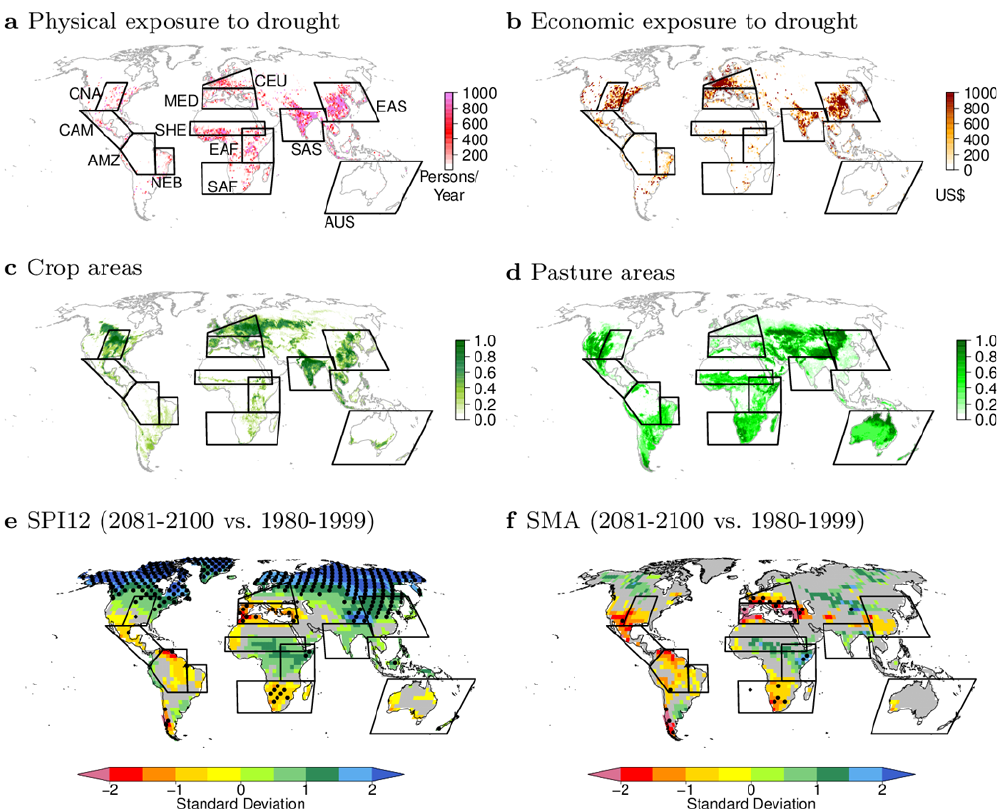
Fig. 1. Exposure to drought, land uses and future changes of drought in CMIP5 projections. (a) Physical exposure to drought measured by the number of persons exposed to drought per year over 1980–2001. (b) Economic exposure to drought in 1980–2001 measured by the expected average annual Gross Domestic Product GDP (2007 as the year of reference) exposed to drought (in US$, year 2000 equivalent). (c) Crop areas as grid cell percentages for the year 2000. (d) Pasture areas as grid cell percentages for the year 2000. (e) Multi-GCM averages of multi-year average changes in 12month Standardised Precipitation Index (SPI12) between present-day (1980–1999) and future (2081– 2100), divided by the standard deviation of annual values with their linear trend over the 1961–2100 period removed. The GCM projections are based on the RCP8.5 GHG concentrations scenario. (f) As (e) , but for changes in average Soil Moisture Anomalies (SMA). Colour shading in (e) and (f) indicates at least 66% of the GCMs agreeing on the sign of change, additional stippling (black dots) indicates 90% agreement. Gray shading indicates less than 66% GCM agreement on the sign, and if stippled (black diamonds), consistent small changes (at least 66% of the GCMs display changes smaller than half a standard deviation). Increased drought is indicated with yellow-red shading. Outlined regions in all maps indicate the hot spots that are analysed in our